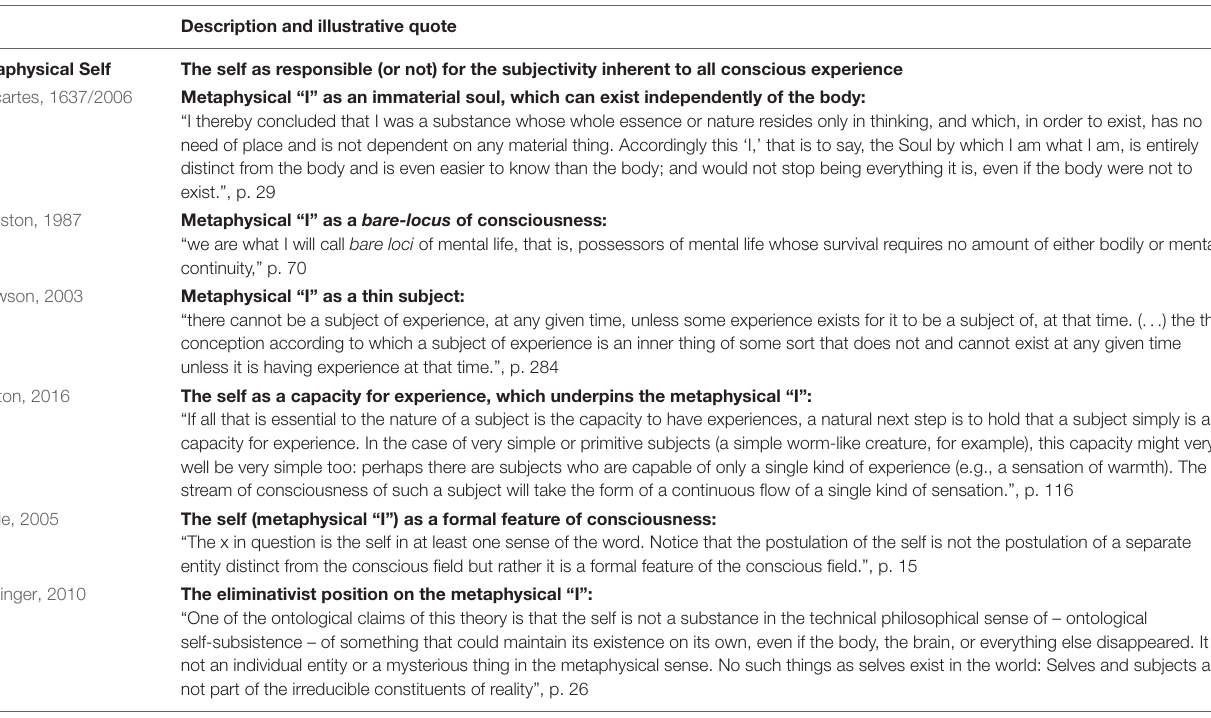
TABLE 3 | Examples of theories of the self-as-subject (“I”) in the context of consciousness, as theories of the metaphysical self, with representative quotes illustrating each position. Description and illustrative